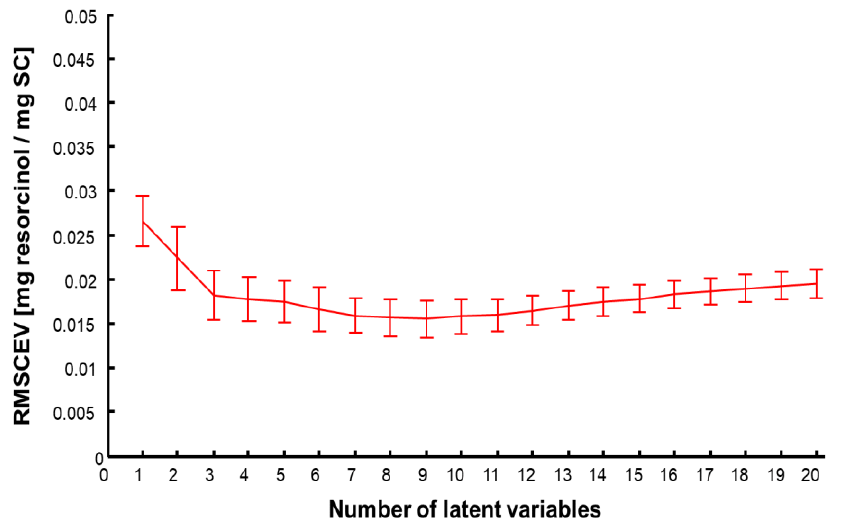
Figure 8. Root mean square error of cross validation (RMSECV).